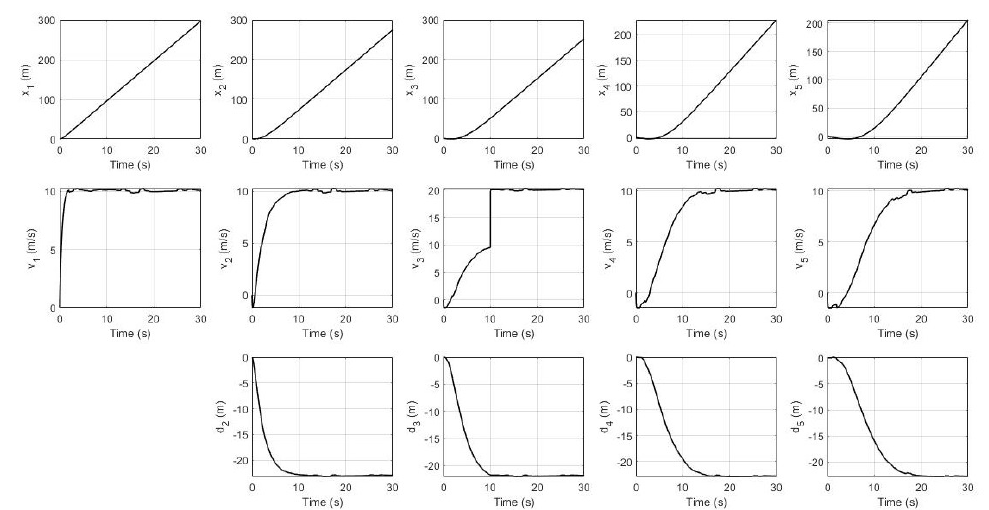
Figure 9. System’s response with sensor S2 fault in the 3rd robot.